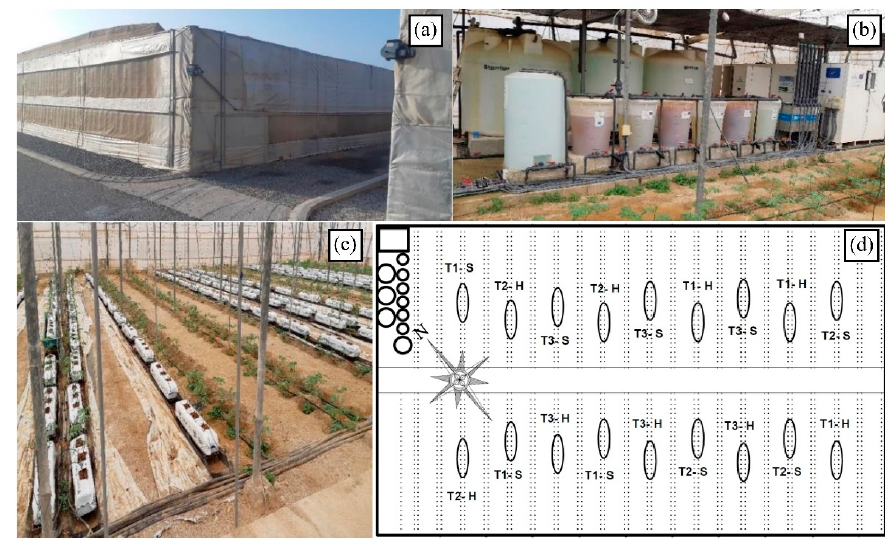
Figure 3. Experimental “ Raspa y Amagado ” greenhouse: ( a ) irrigation installation; ( b ) plants in typical soil substrate and in coconut fiber substratep ( c ) orrigation treatments and powdery mildew plot assessment distribution; ( d ) treatments T1, T2 and T3; S, typical soil substrate “ enarenado ”; H, coconut fiber substrate.